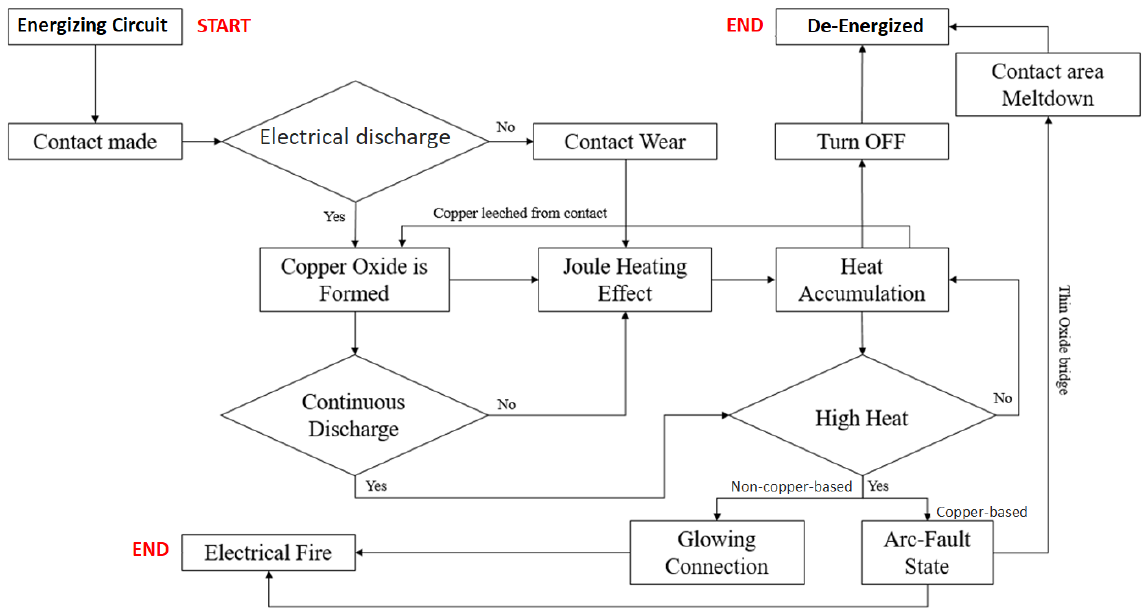
Figure 15. The process that leads to electrical fires from accumulated heat and arc-fault states. A fire hazard from a glowing connection can be accelerated by an arc fault, as is explained in the steps below.